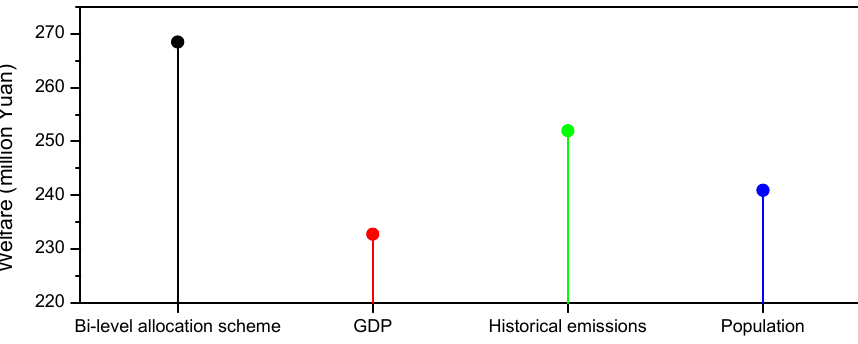
Figure 9. Total welfares of different quota allocation schemes under target 1.